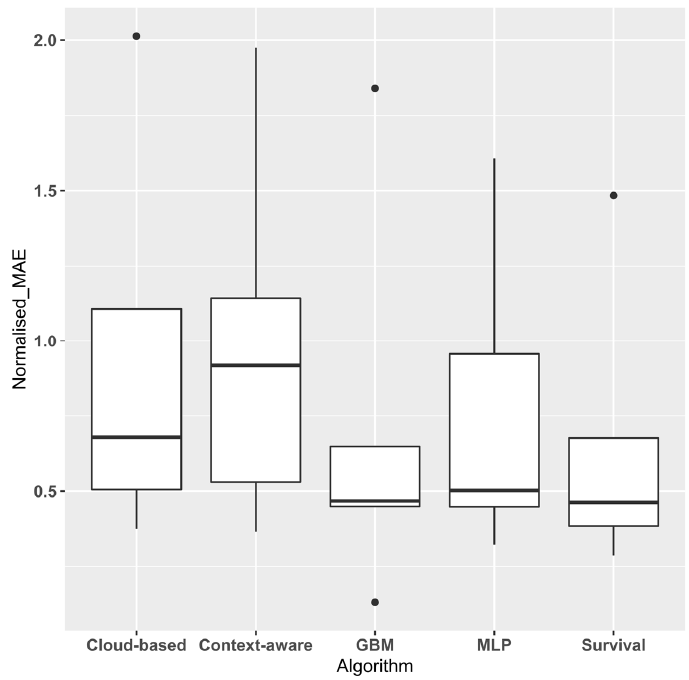
Algorithms 2020 , 13 , x FOR PEER REVIEW Figure 5. Average Normalised MAE. Figure 5. Average Normalised MAE.